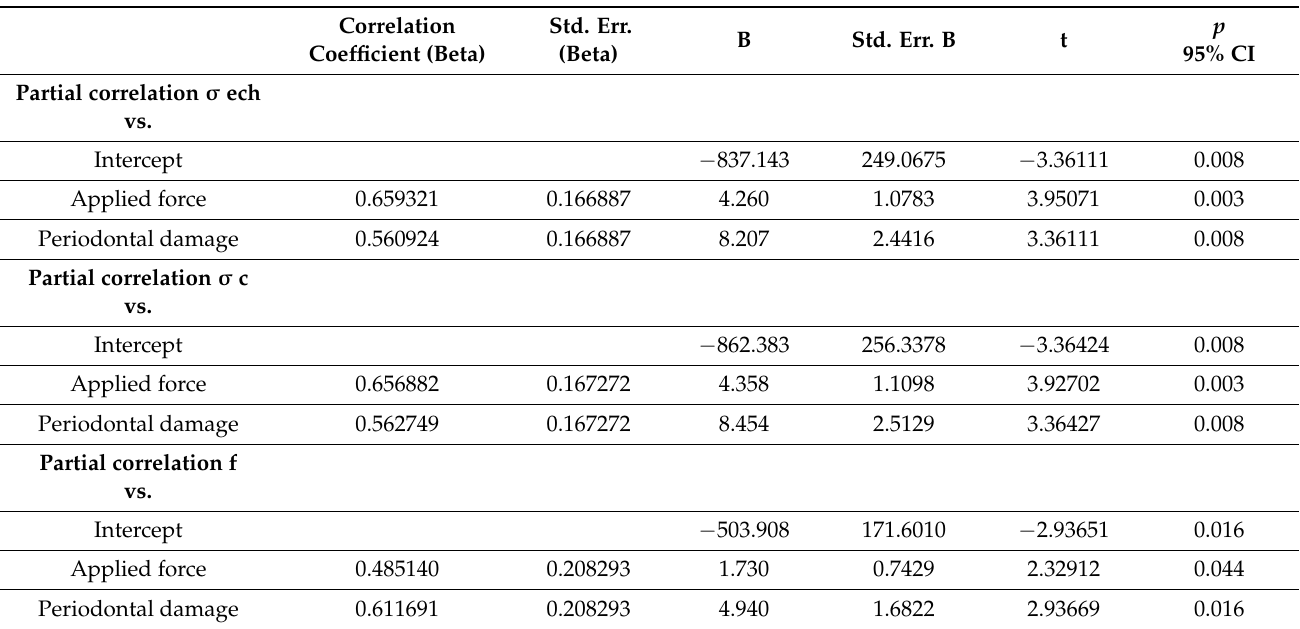
Table 5. Results of the multivariate analysis—partial correlation coefficient σ ech, σ c, and f. Correlation Std. Err. B Std. Err. B t Coefficient (Beta) (Beta)